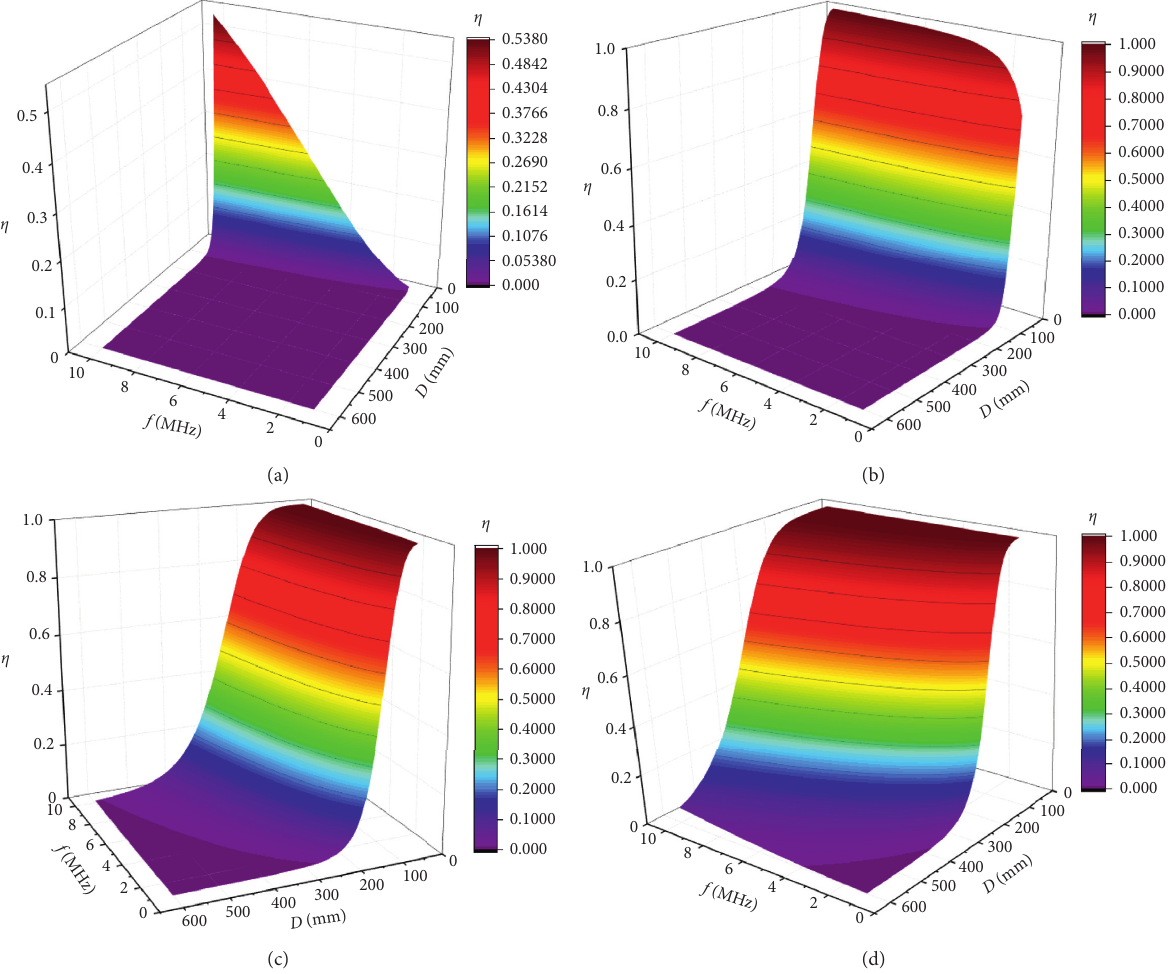
Figure 6: Variation of η with f and D . (a) Coil diameter of 200mm. (b) Coil diameter of 400mm. (c) Coil diameter of 700mm. (d) Coil diameter of 900mm.